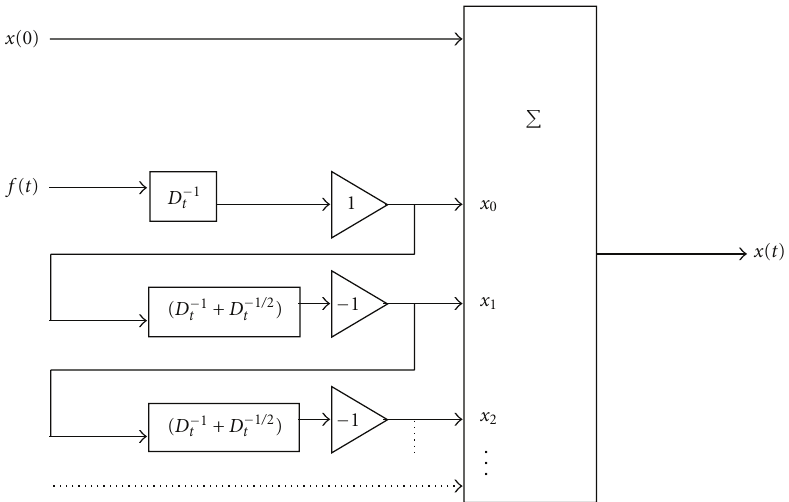
Figure 3: Block showing solution of first order di ff erential equation by decomposition in presence of fractional half order term.